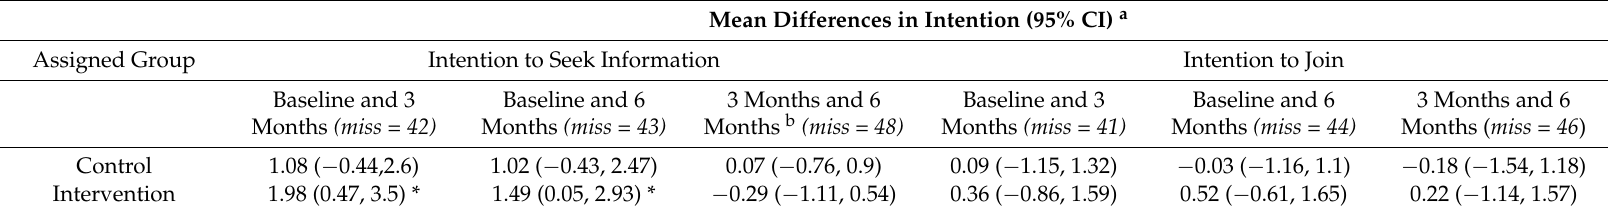
Table 4. Estimated marginal mean changes in clinical trial